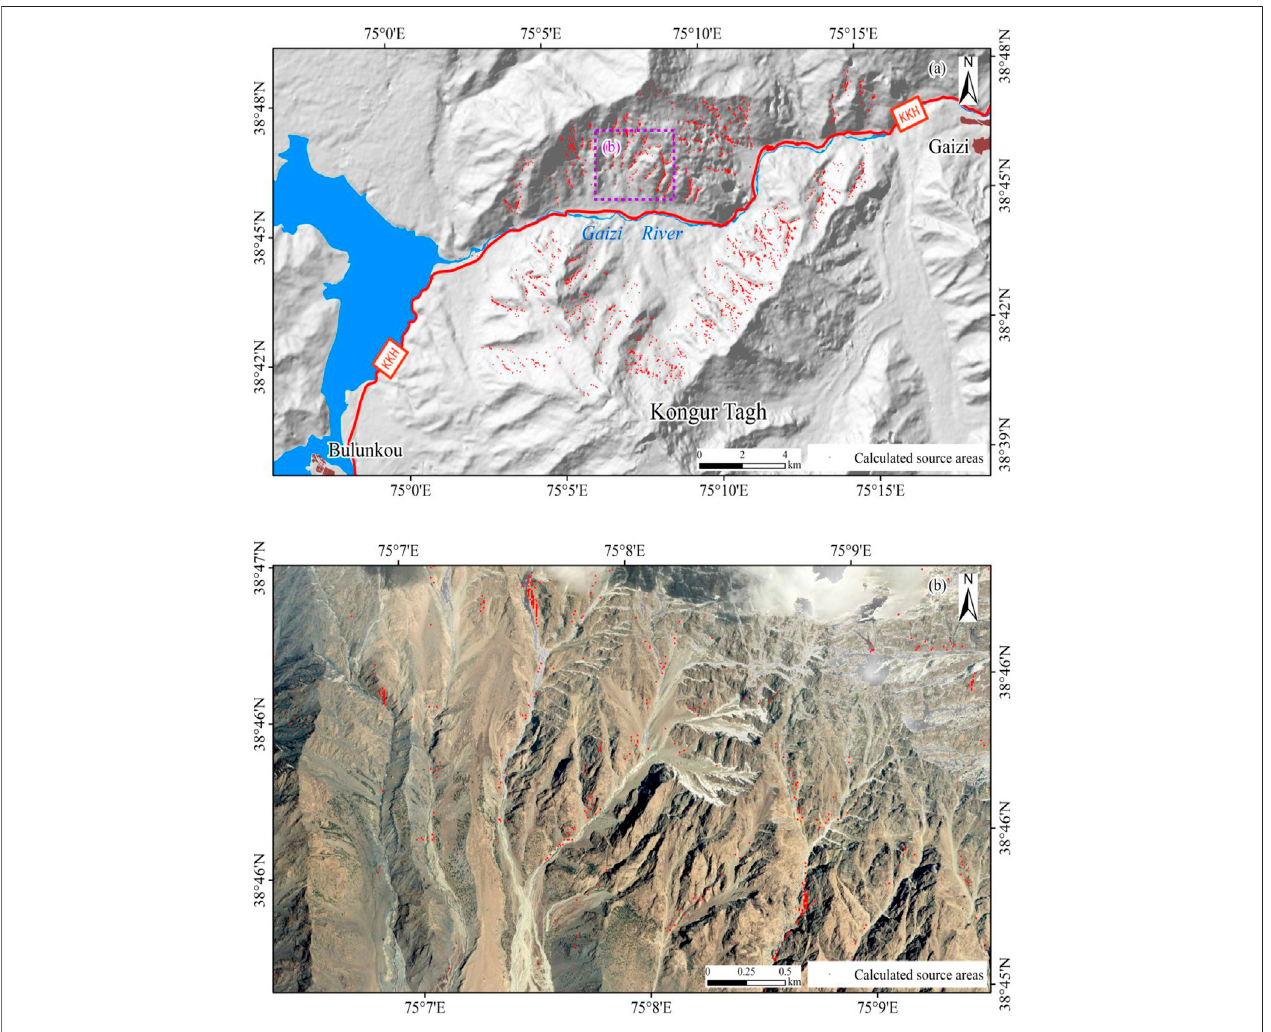
FIGURE 6 | The source areas map calculated from the Flow-R. (A) General map; (B) Detailed map. The source area grids in the map are expanded to 50 × 50 m because 10 m × 10 grids are dif fi cult to display.